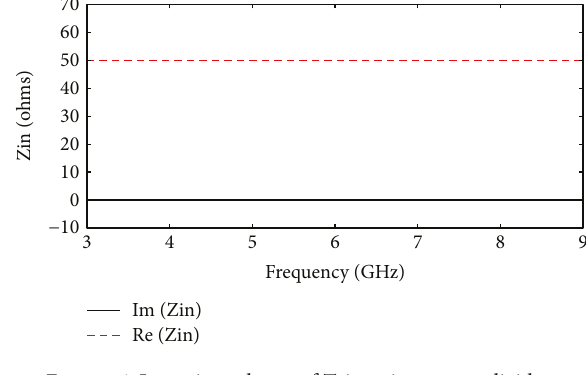
Figure 6: Input impedance of T-junction power divider.